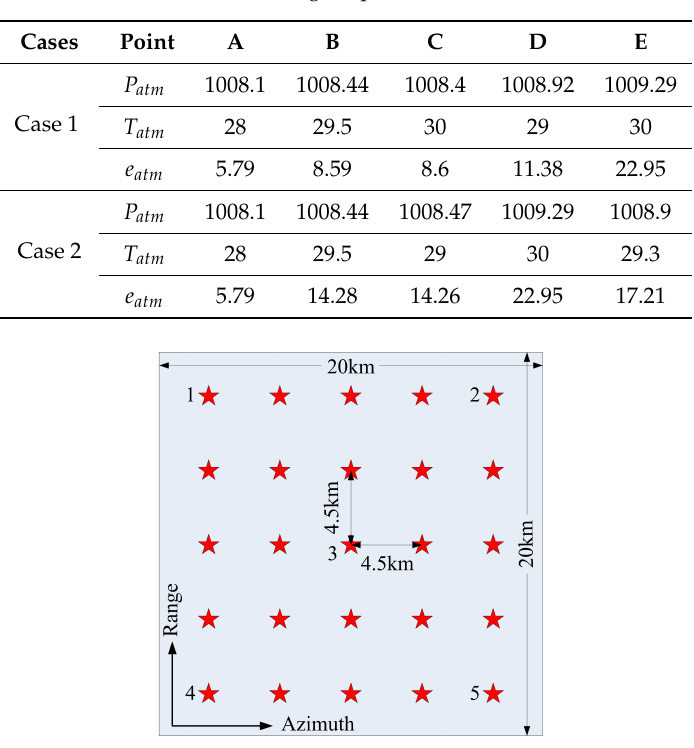
Figure 12. Point target distribution in the scene.